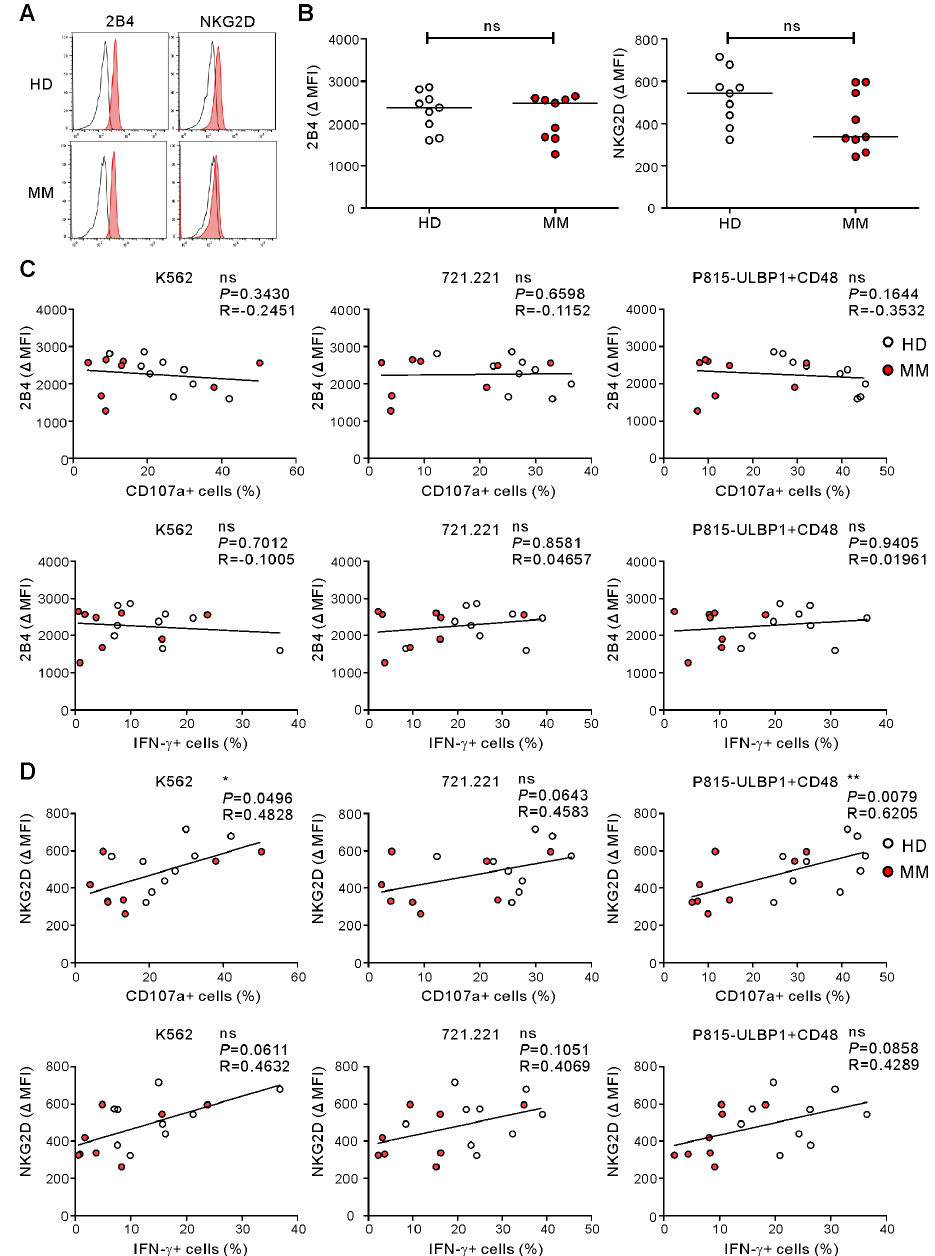
Figure 4. NKG2D expression is associated with NK cell degranulation in response to receptor coactivation. ( A ) Representative FACS profiles showing the expression of NKG2D and 2B4 on gated NK cells in the HD group and MM group. ( B ) Shown is the mean fluorescence intensity (MFI) of the expression of 2B4 and NKG2D on NK cells relative to the MFI of the isotype control ( Δ MFI) in the HD group ( n = 9) and MM group ( n = 9). ( C ) Correlation between 2B4 expression ( Δ MFI) and the frequencies of CD107a+ or IFN- γ + NK cells. ( D ) Correlation between NKG2D expression ( Δ MFI) and the frequencies of CD107a+ or IFN- γ + NK cells. * p < 0.05 and ** p < 0.01; Spearman’s correlation test.